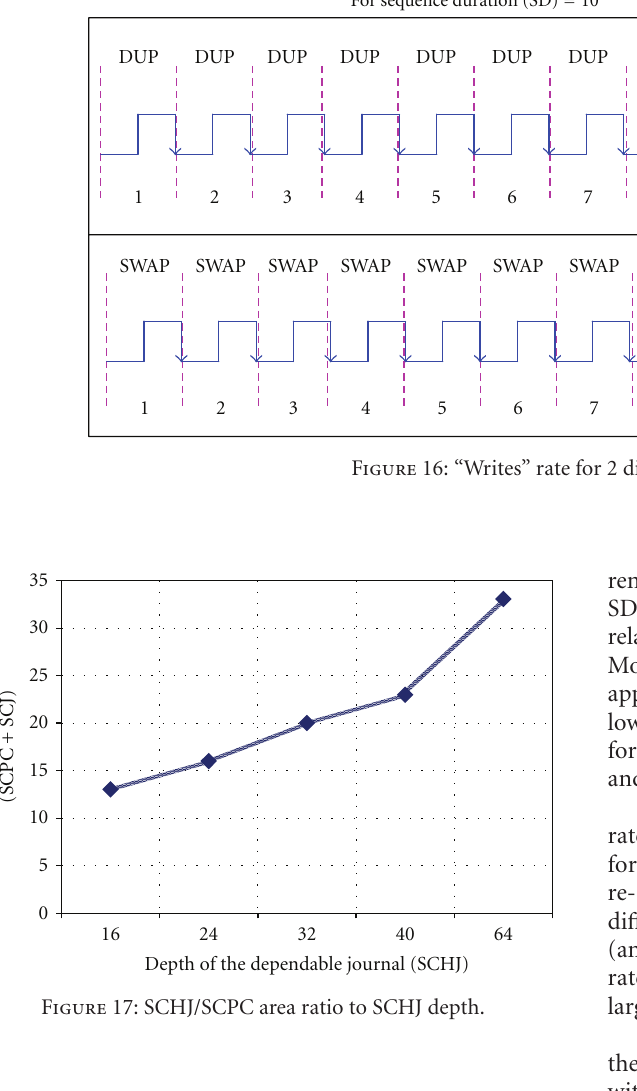
Table 3: Read/Write profiles in benchmarks